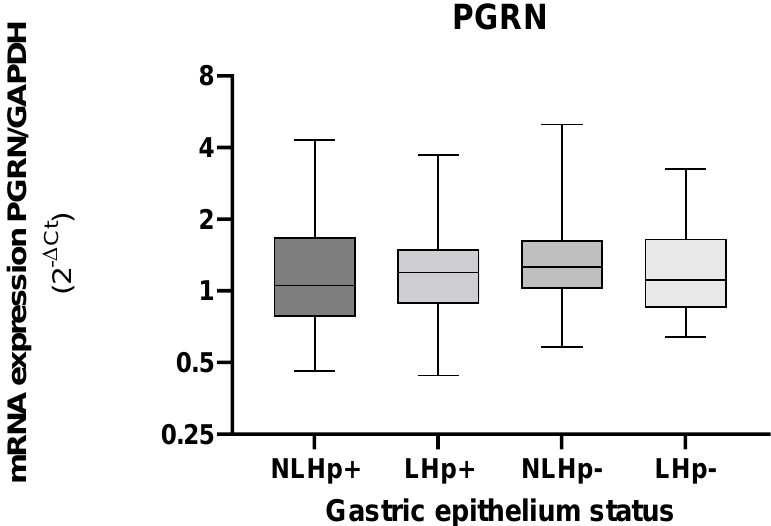
Figure 1. The GRN expression in gastric tissue from individuals infected and uninfected with H. pylori . The GRN expression values calculated by formula 2 − ∆ Ct , where ∆ Ct = Ct of GRN − Ct of GAPDH. The Mann–Whitney test was used for the analyses between the groups. Statistical significance p < 0.05.